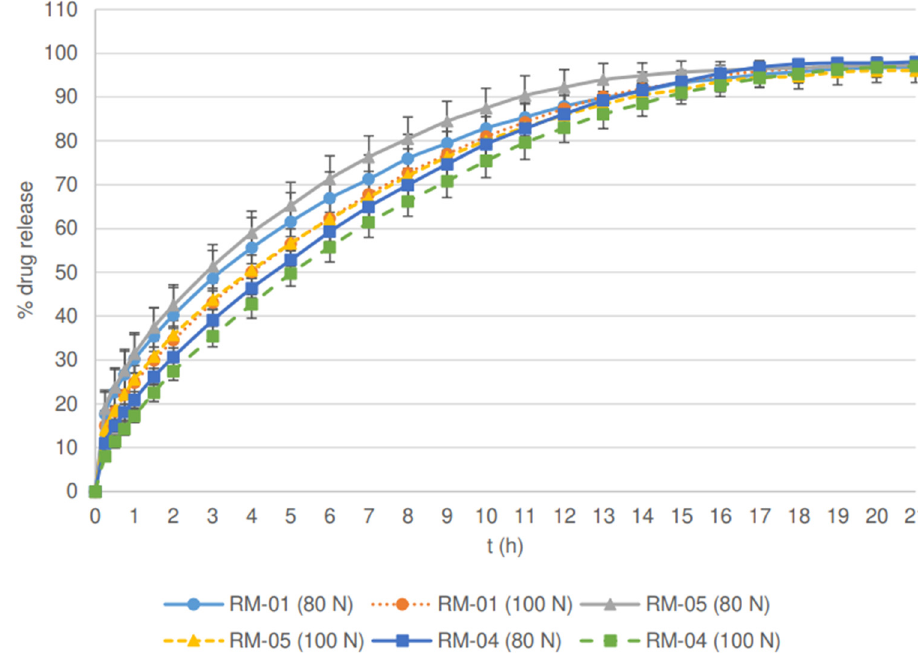
Figure 7. Effect of roll speed and tablet hardness on % drug release from matrix tablets containing MCC as a filler.